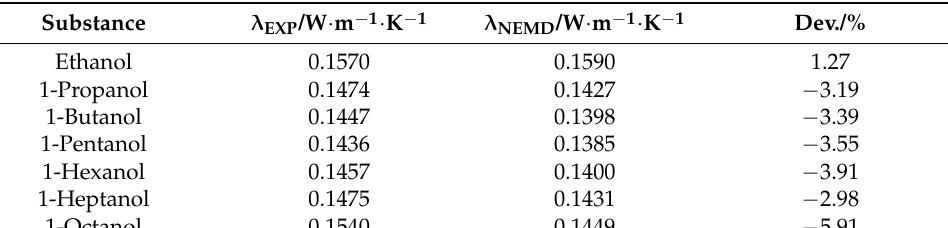
Table 6. Comparison between experimental and simulated values of thermal conductivity for seven kinds of n-alcohols at 323.15 K.